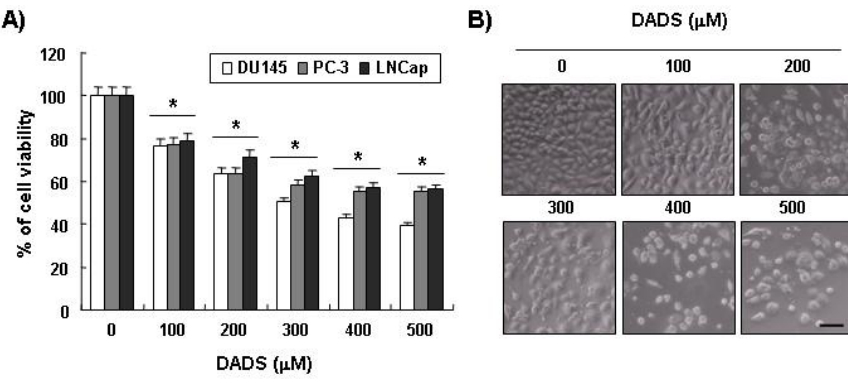
Figure 1. Effects of DADS on cell viability in human prostate cancer cell lines. ( A ) The cells (DU145, PC-3 and LNCap) were treated with the indicated concentrations of DADS for 48 h. The cell viability was measured by the metabolic-dye-based MTT assay. Each point represents the mean ± SD of three independent experiments. The significance was determined by the Student's t -test ( * p < 0.05 vs. untreated control). ( B ) DU145 cells grown under the same conditions as ( A ) were sampled and photographed under an inverted microscope (original magnification 200×). Scale bar is 50